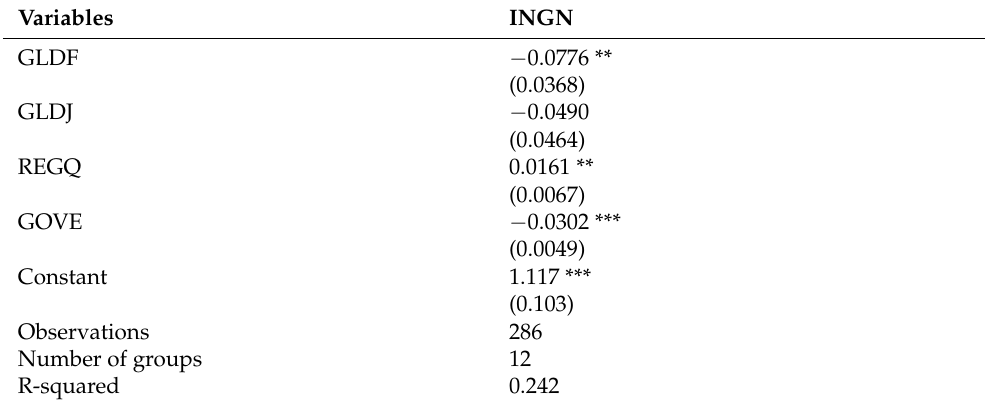
Table 11. Model 1. DV: Income Inequality Gini Coefficient